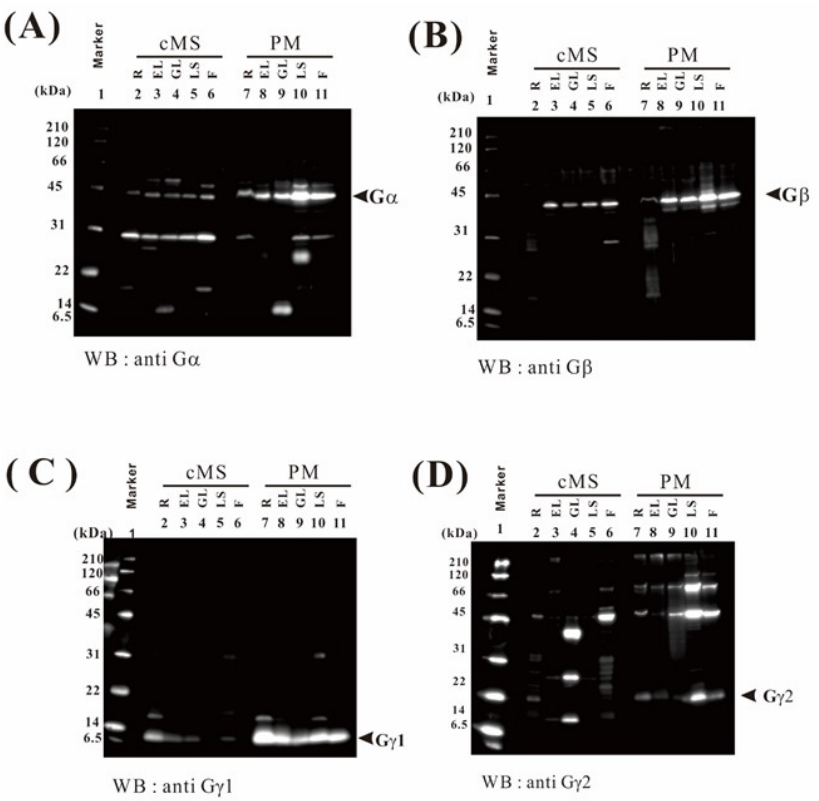
Figure 7. Immunoblot analysis of the G α , G β , G γ 1, and G γ 2 subunits in rice. Proteins (10 µ g) in crude microsomal fraction (cMS) and plasma membrane fractions (PM) of the root (R), etiolated leaf (EL), green leaf (GL), leaf sheath (LS), and flower (F) were separated by SDS-PAGE and cross-reacted with the anti-G α antibody ( A ), anti-G β antibody ( B ), anti-G γ 1antibody ( C ), and anti-G γ 2 antibody ( D ). The G α , G β , G γ 1, and G γ 2 subunits are indicated with arrows. Int. J. Mol. Sci. 2020 , 21 , x FOR PEER REVIEW